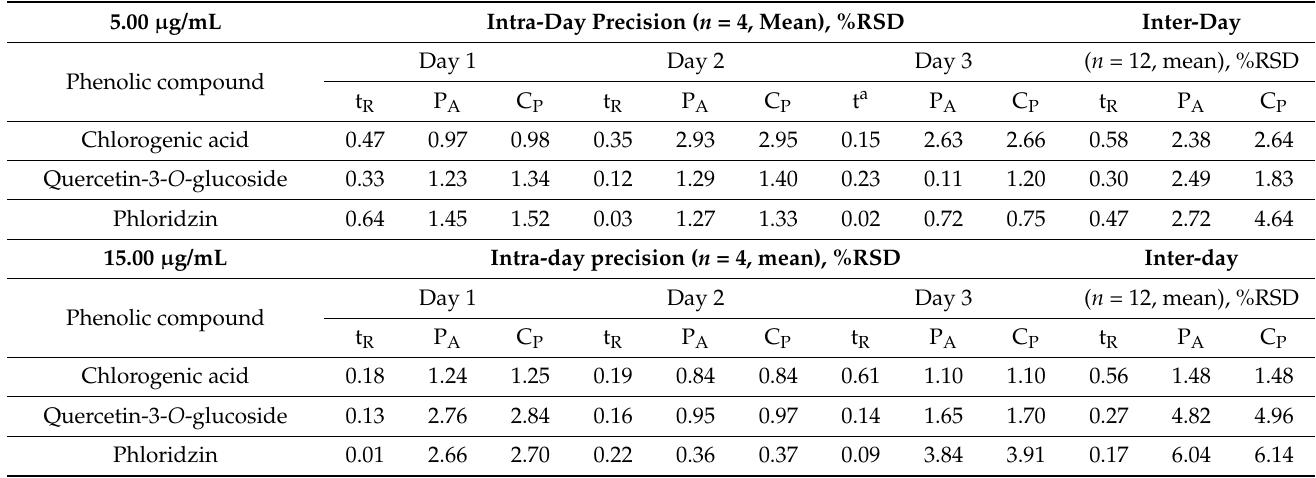
Table 3. Evaluation of precision (%RSD) for retention times (t R ), peak areas (P A ), and polyphenol concentrations (C P ) at two different concentrations (5.00 and 15.00 µ g/mL).